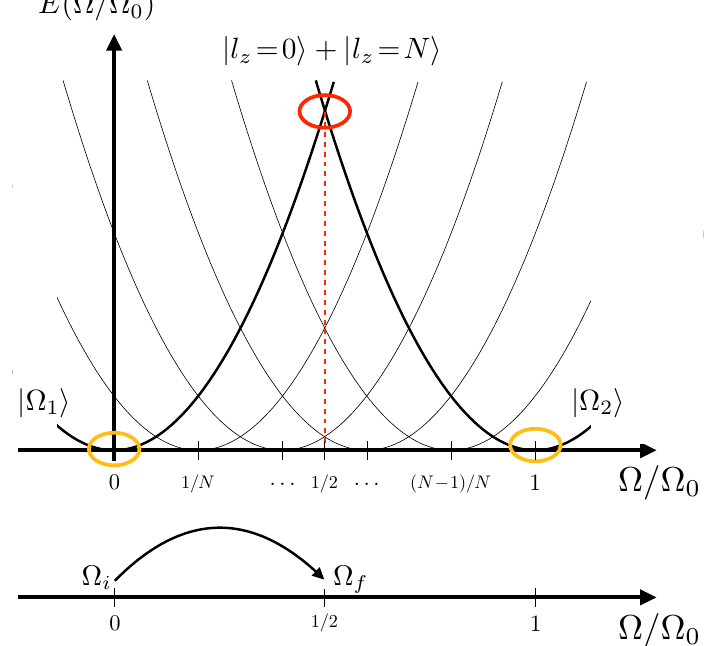
Figure 4: Schematic representation of the protocol. By quenching the flux in the / 2, the two states | Ω system from 0 to Ω 0